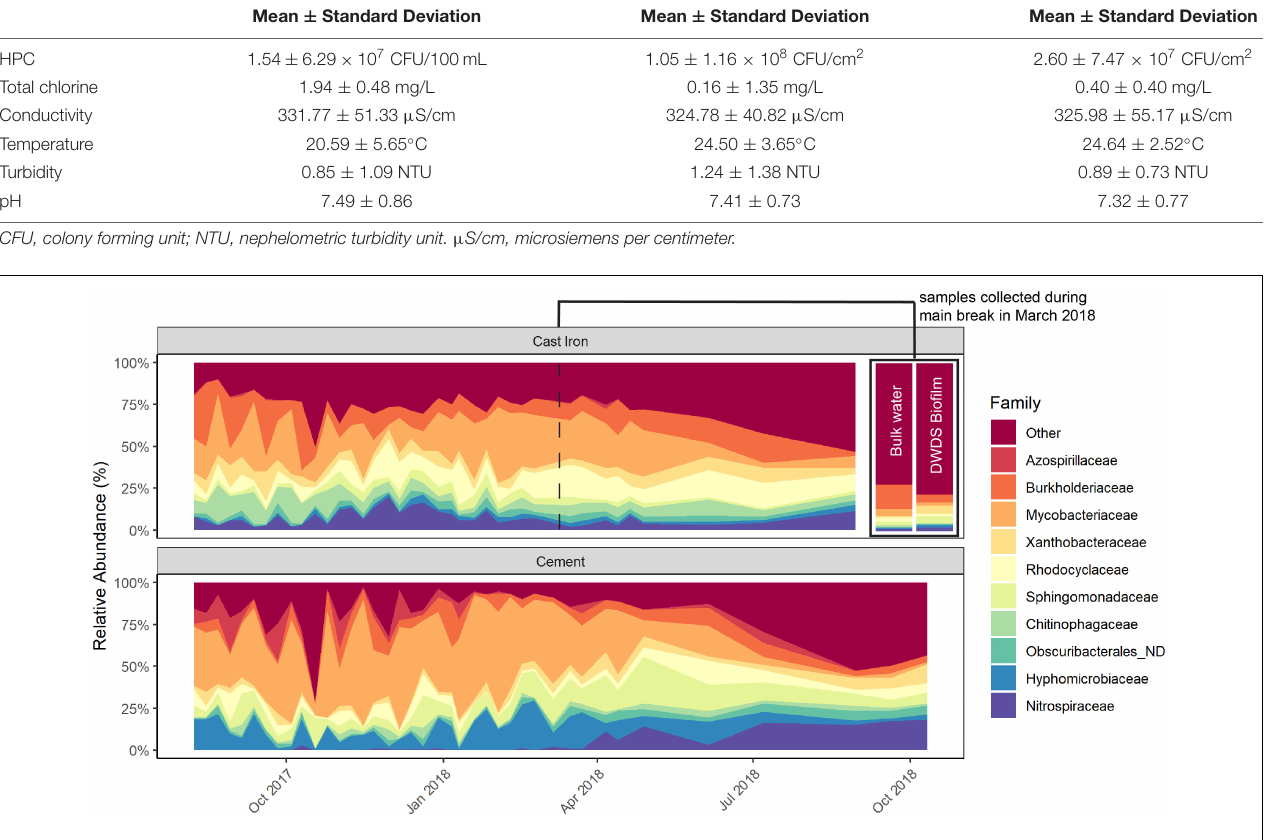
FIGURE 2 | Relative abundance of the most prevalent taxa in cast iron and cement annular reactor (AR) biofilm samples over the 16-month study period. At each time point, one coupon was collected from the set of cast iron ARs and the set of cement ARs. One coupon from each set was collected weekly for the first 34 weeks and then monthly for four additional months (cast iron ARs) and six additional months (cement ARs). A total of 38 coupons from the cast iron ARs and a total of 40 coupons from the cement ARs were collected. The relative abundance of the top AR taxa in bulk water and drinking water distribution system (DWDS) pipe biofilm collected during the main break in March 2018 can be found in the top right